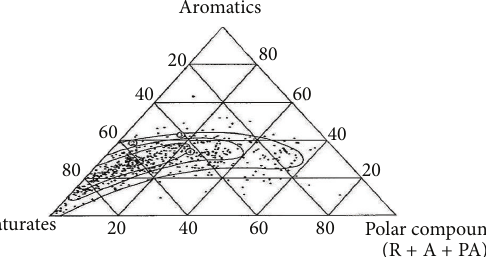
Figure 4: Compositional representation on ternary diagram of 640 different crudes